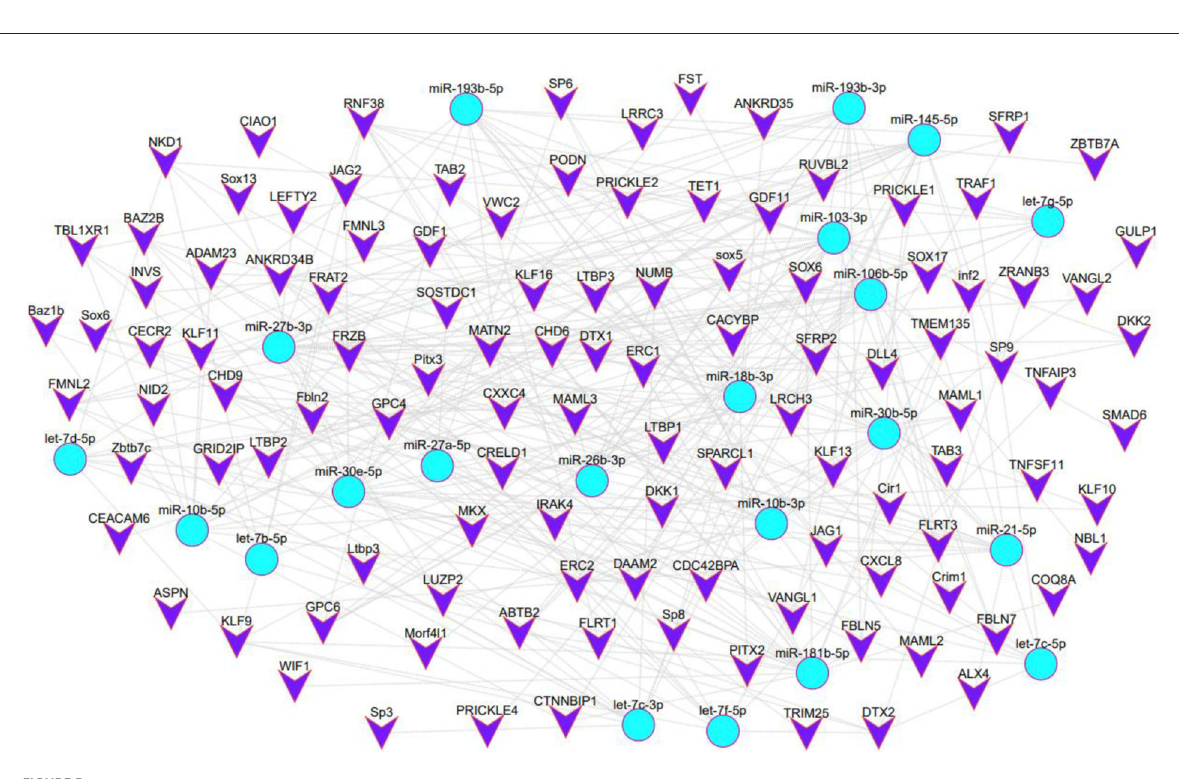
regulatory network related to secondary follicle morphogenesis and development (Figure 4). Bioinformatics predicted its target genes, screened 110 target genes enriched in Wnt, TGF- β ,